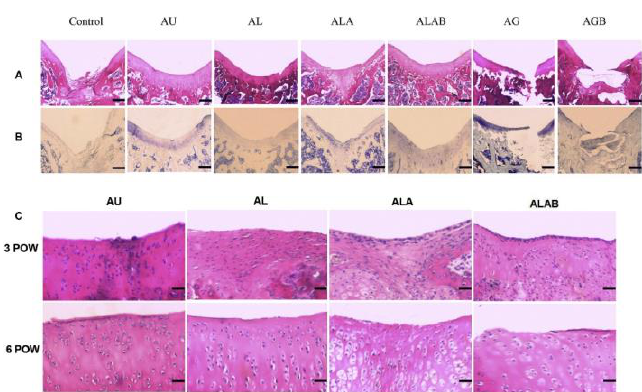
Figure 5. cartilage injury after transplantation of different groups: ( i ) nontransplant control, ( ii ) autologous articular cartilage (AU), ( iii ) allogeneic (same species, different rat) articular cartilage (AL), ( iv ) allogeneic articular cartilage replacing agarose gel (ALA), ( v ) allogeneic articular cartilage replacing agarose gel with bFGF (ALAB), ( vi ) agarose gel (AG), and ( vii ) agarose gel with bFGF (AGB). The cartilage restoration evaluation was drastically greater in the AU group than that in the AL group, as was the ALAB group compared with the ALA group. Assessment of histological data after transplantation. ( A , B ) Nontransplant control: amorphous reparative tissue filling the subchondral region. AU: intensive staining covering the defect. AL: the intensity of staining in the regenerated region was less than that of AU and ALAB. ALA: partly positive cartilage organization in the area. ALAB: amounts of cartilage-like tissue restored in the full-thickness defect. AG and AGB showed the agarose gel occupied the space and hindered the reconstructive process. ( C ) Histological findings in knee cartilage in the transplantation site at postoperative week (POW) 3 and POW 6 (hematoxylin and eosin). At POWs 3 and 6, the ALAB and AU groups showed no obvious evidence of rejection. In the other two groups, chondrocytes with small, condensed nuclei were visible at each time point. Scale bar is 50 µ m for all images (Reprinted with permission form